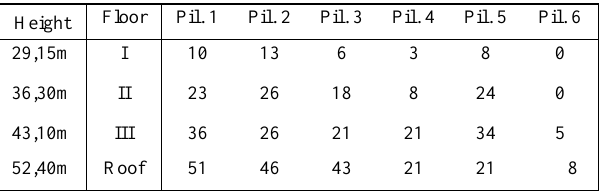
Table 1. Out of plane displacement (cm) of the columns analysed.